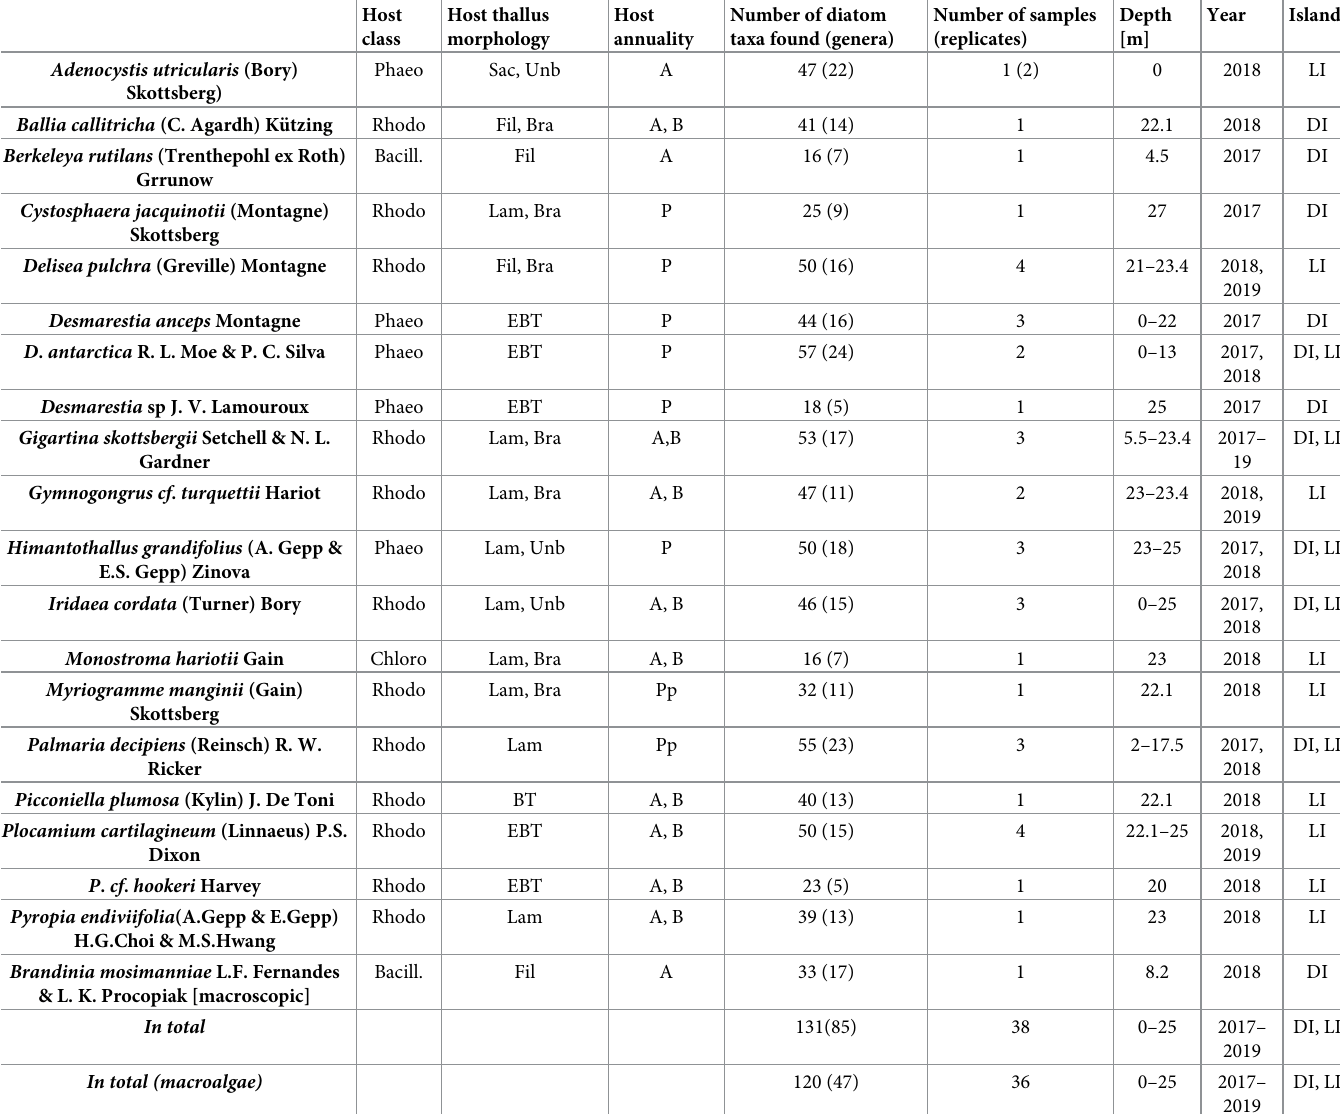
Table 1. Sample descriptions: Number of samples, replicates and macroalgal